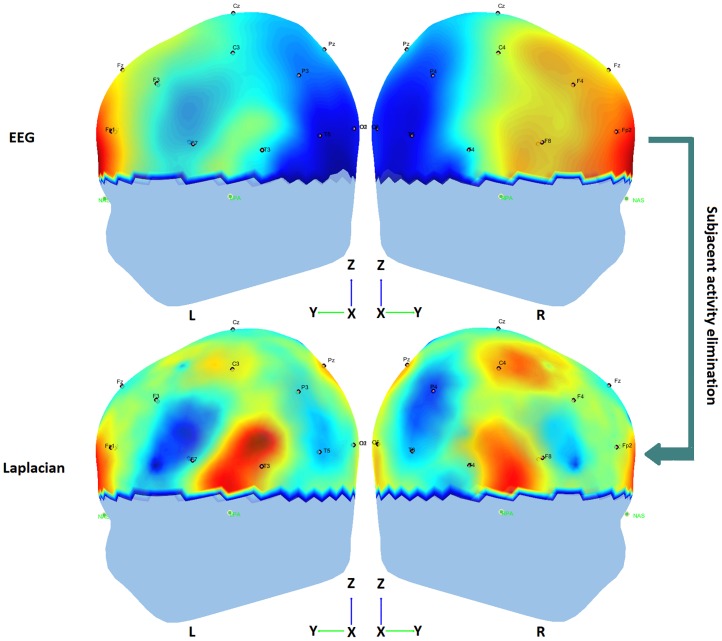
Graphic representation of the effect of Laplacian spatial filtering in one high-achievement subject during task onset.